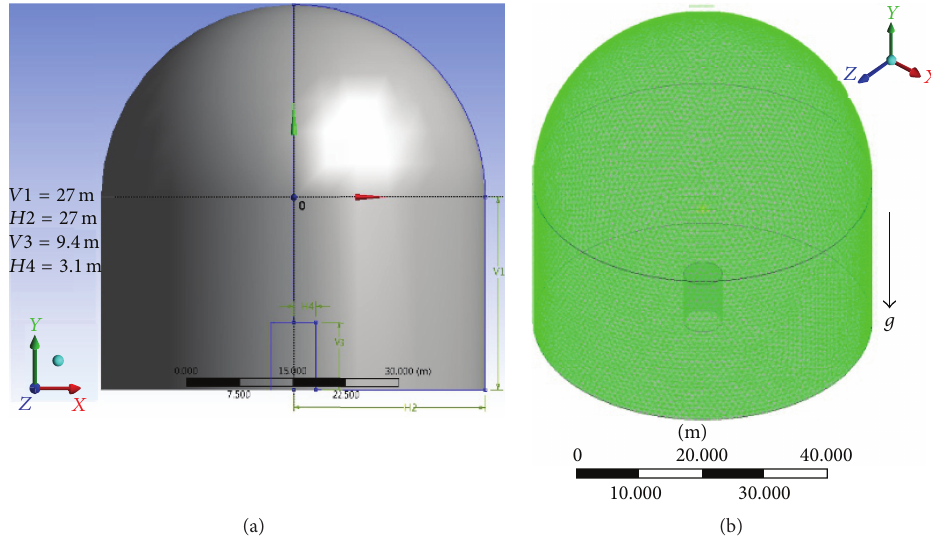
Figure 1: Geometry (a) and mesh (b) for CFD